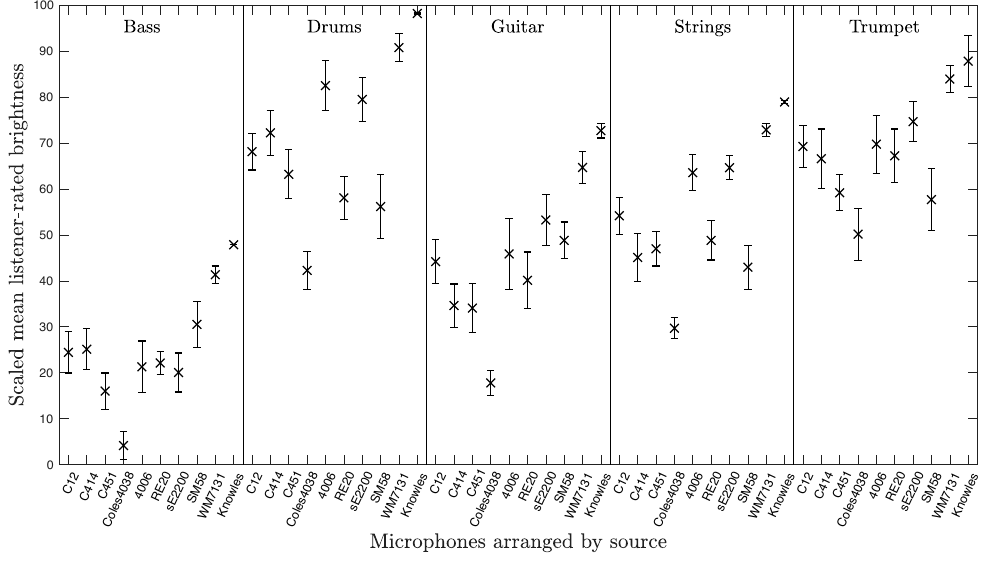
Figure 2. Listener ratings of brightness. Data for each source (from test part 1) have been scaled according to the cross-source ratings of the most and least bright recordings of that source (from test part